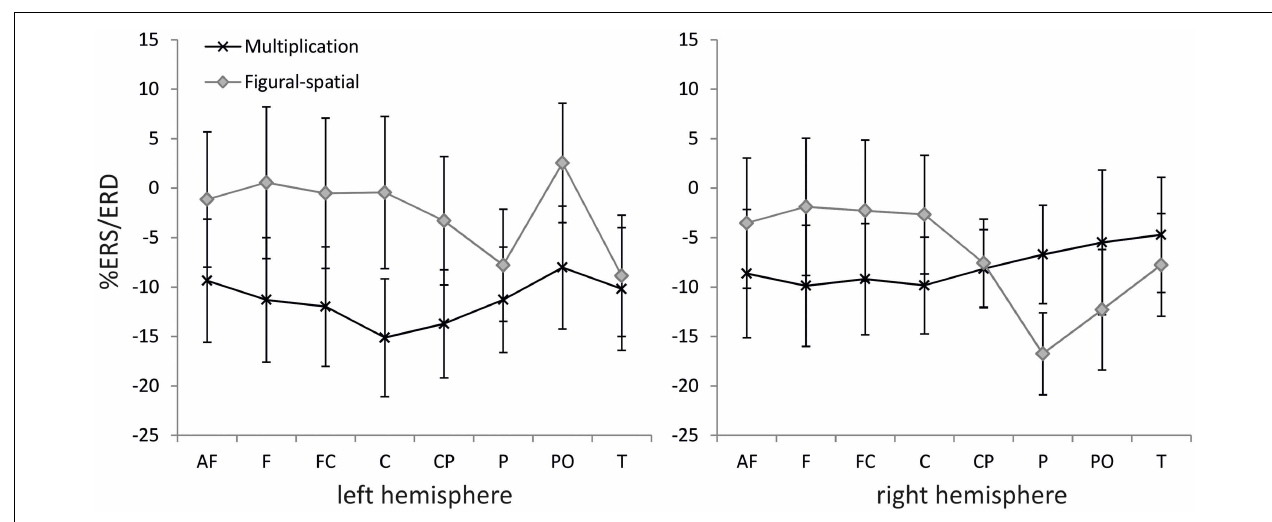
FIGURE 6 | Effect of task on %ERS/ERD in the lower alpha band (8–10Hz). Error bars depict 1 SE of the mean. AF, anteriofrontal; F, frontal; FC, frontocentral; C, central; CP, centroparietal; P, parietal; PO, parietooccipital;T,